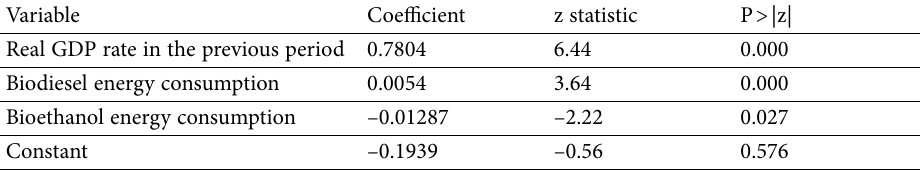
Table 2. System dynamic panel data estimation for explaining economic growth in the EU-28 countries during 2010–2015 using the biodiesel and bioethanol energy consumption in transport Variable Coefficient z statistic P > |z| Real GDP rate in the previous period 0.7804 Biodiesel energy consumption 0.0054 Bioethanol energy